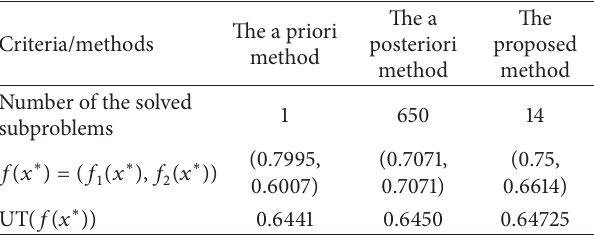
Table 14: Comparison of the results of the a priori method, the a posteriori method, and the proposed